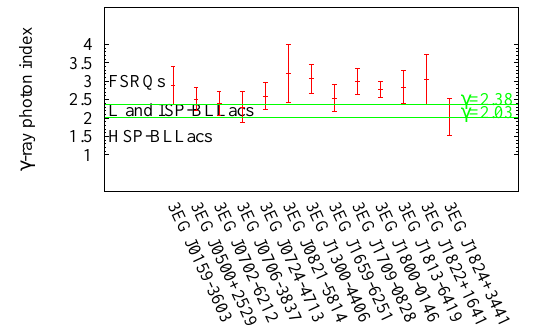
Figure 2: Gamma-ray photon spectral indices of the EGRET sources between 30 MeV - 10 GeV.